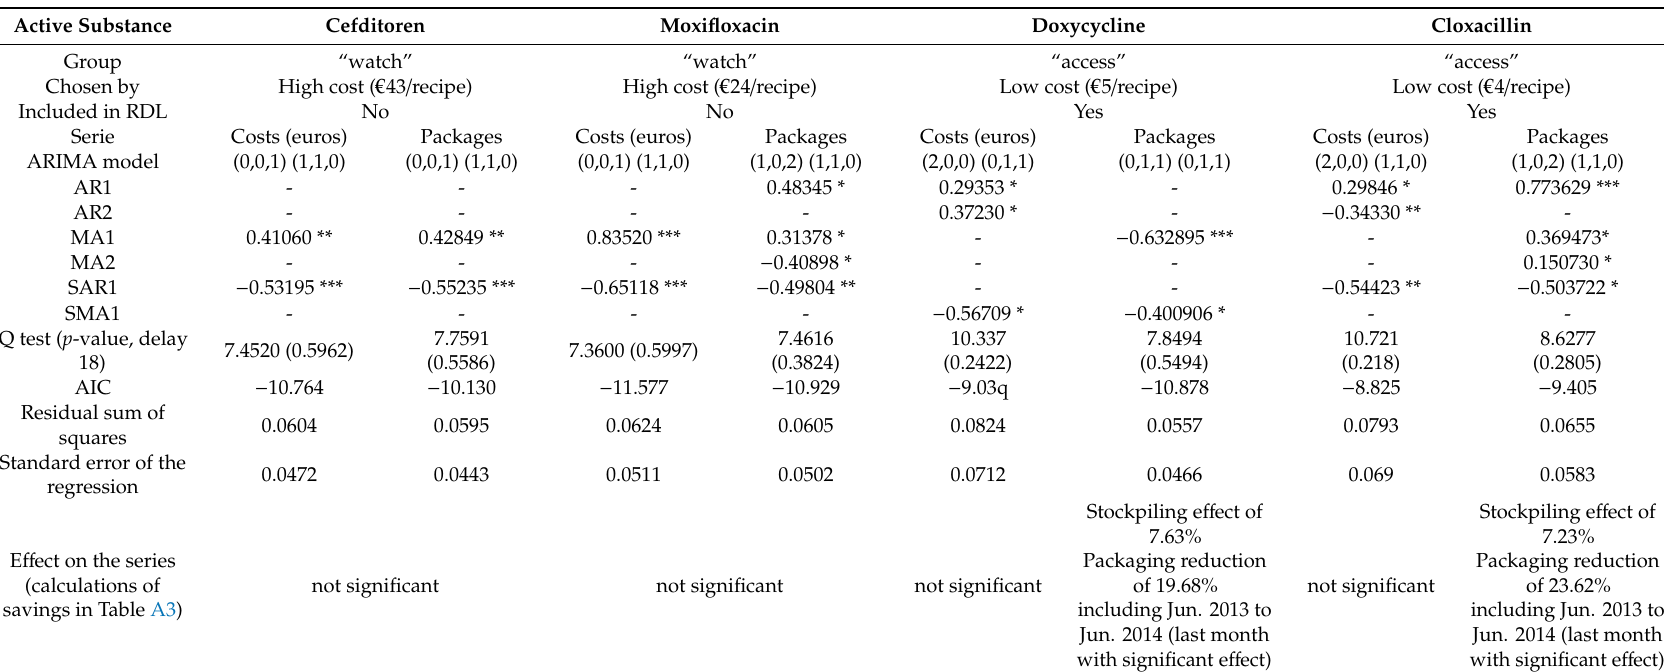
Table A2. Counterfactual analysis of the series of costs and packages by active substance. Real values from January 2009 to May 2013 and predictions from June 2013 to June